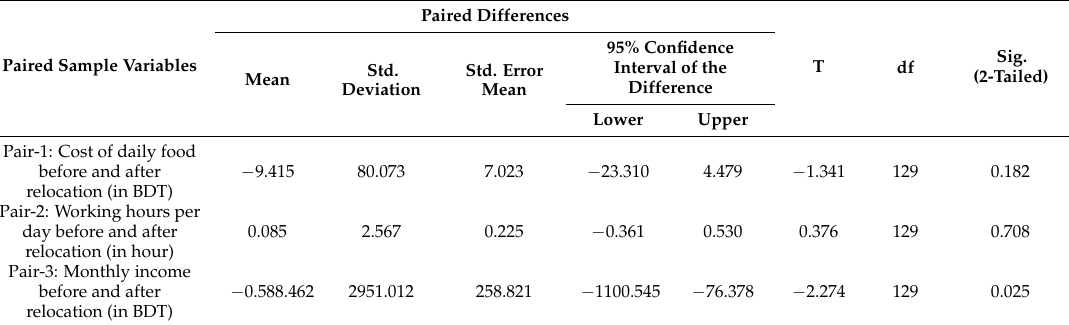
Table 5. Income, expenditure, and working hours before and after